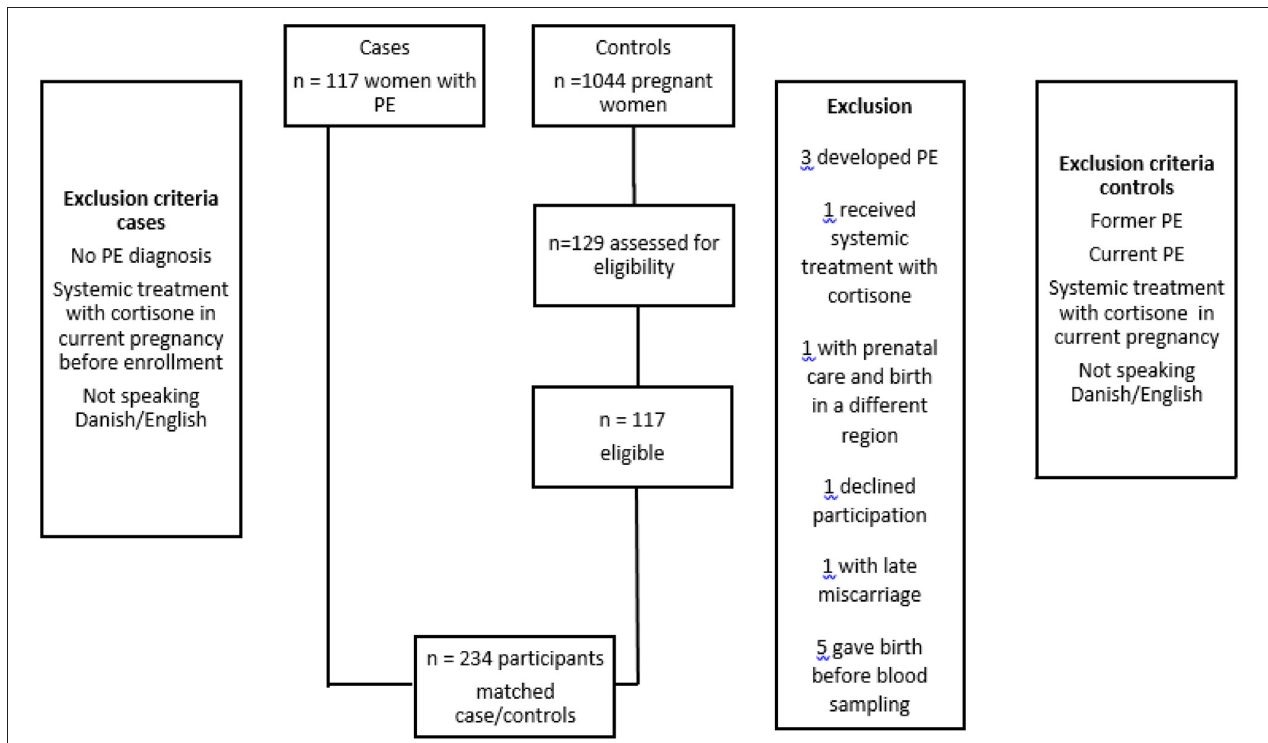
FIGURE 1 | Patients with preeclampsia (PE) and controls enrolled in the PreCas-study. All invited PE-patients (117) accepted to participate. The control group consisted of 1,044 patients and 129 were assessed as eligible. Twelve controls were excluded from the study based on the exclusion